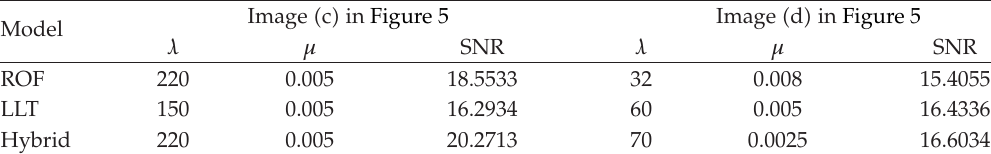
Figure 5: The related images in Example 4.12. Table 3: The related results in Example